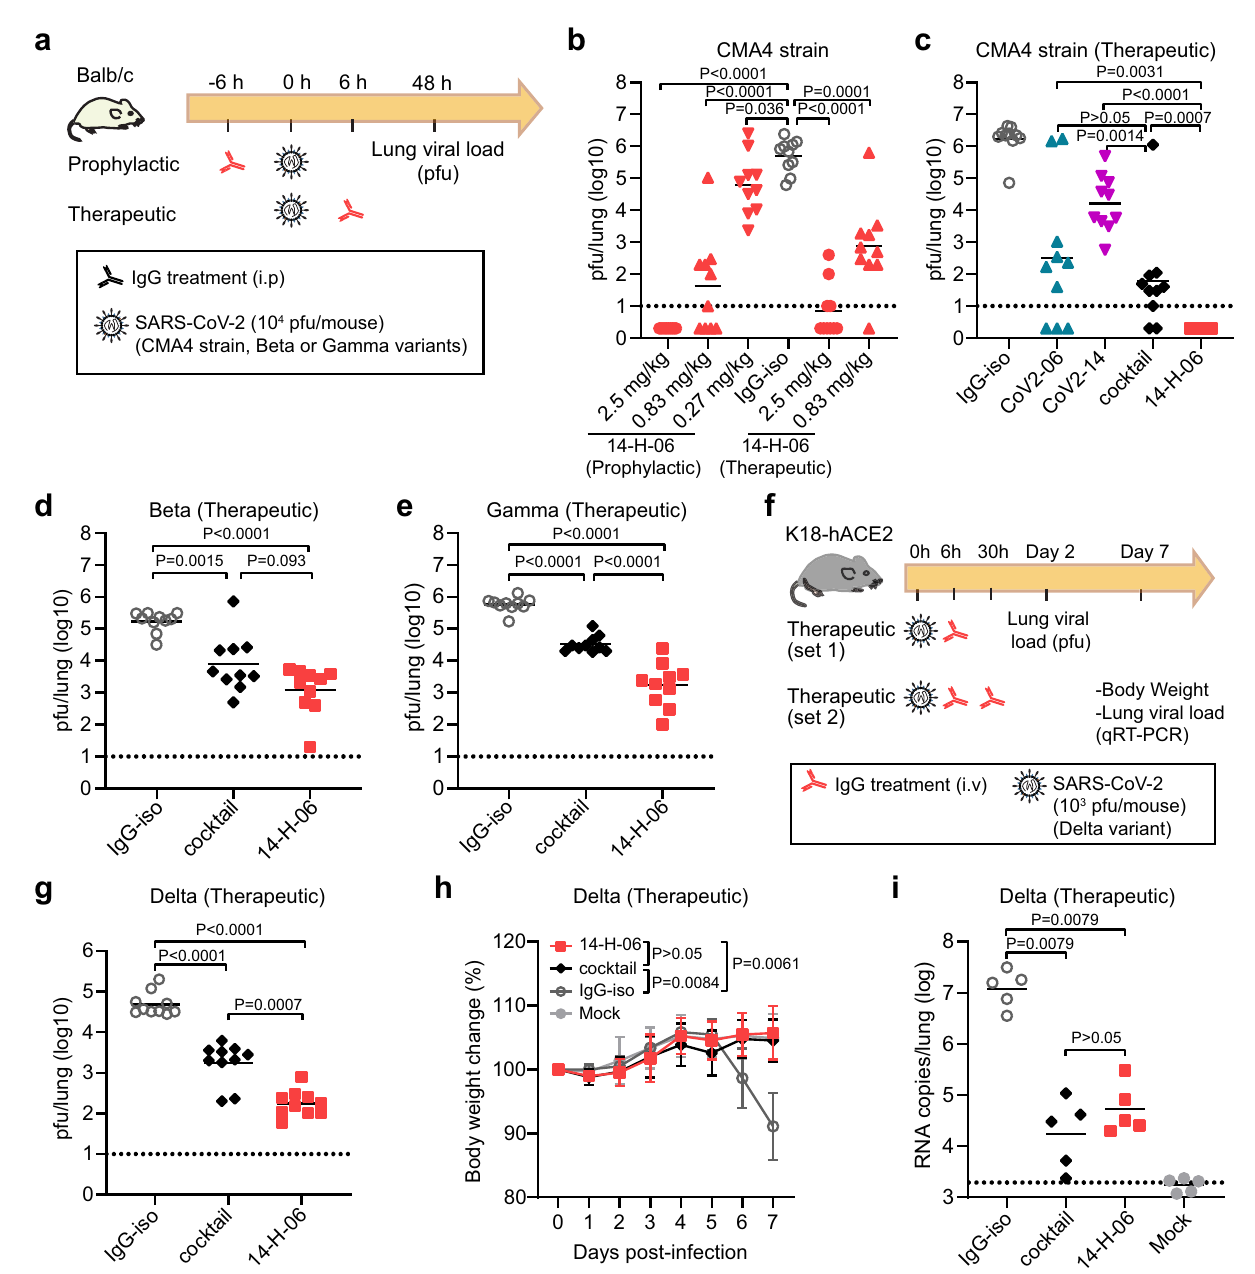
Fig. 5 | In vivo comparisons of 14-H-06 and cocktail against SARS-CoV-2 and variants.a Experimentaldesignforevaluationsoftheprophylacticandtherapeutic effects of antibodies in the Balb/c mouse model of infections. Three SARS-CoV-2 viruses were tested, including a mouse-adapted CMA4 strain containing the spike N501Y mutation and representing the Alpha variant, and the Beta and Gamma variants. b The viral loads were determined by the pfu assay in the dose-range evaluations of the prophylactic and therapeutic effects of 14-H-06 against the CMA4virus. c – e Theviralloadsweredeterminedbythepfuassayintheevaluations ofthetherapeuticeffectsofindicatedantibodiesatthedoseof5mg/kgagainstthe CMA4 virus ( c ), the Beta variant ( d ), and the Gamma variant ( e ). f Experimental design for evaluating the therapeutic effect of 14-H-06 against the Delta variant in the transgenic K18-hACE2 mouse model. In experiment set 1, mice were treated